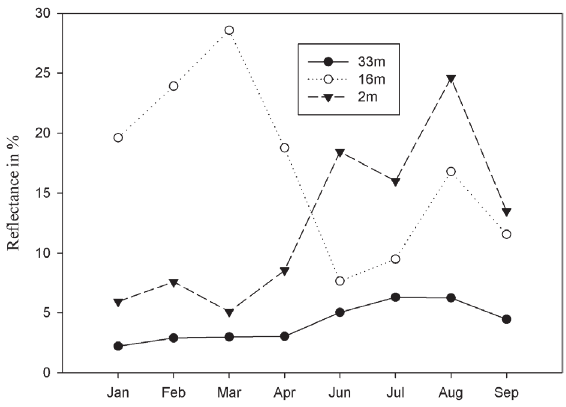
Figure 4 - Mean monthly reflectance at three heights, calculated for the years 2008 to